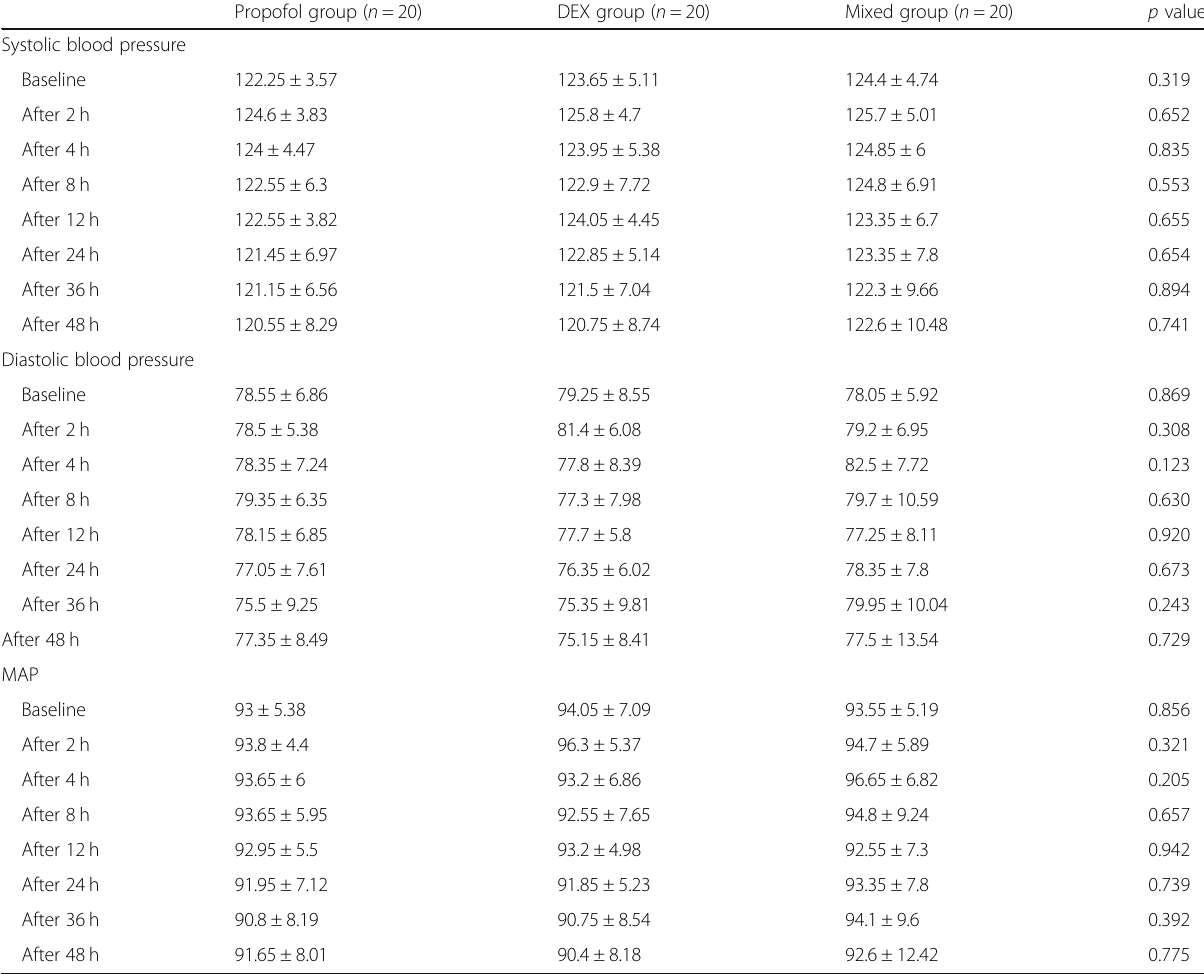
Table 2 Blood pressure changes in the studied groups Propofol group ( n =